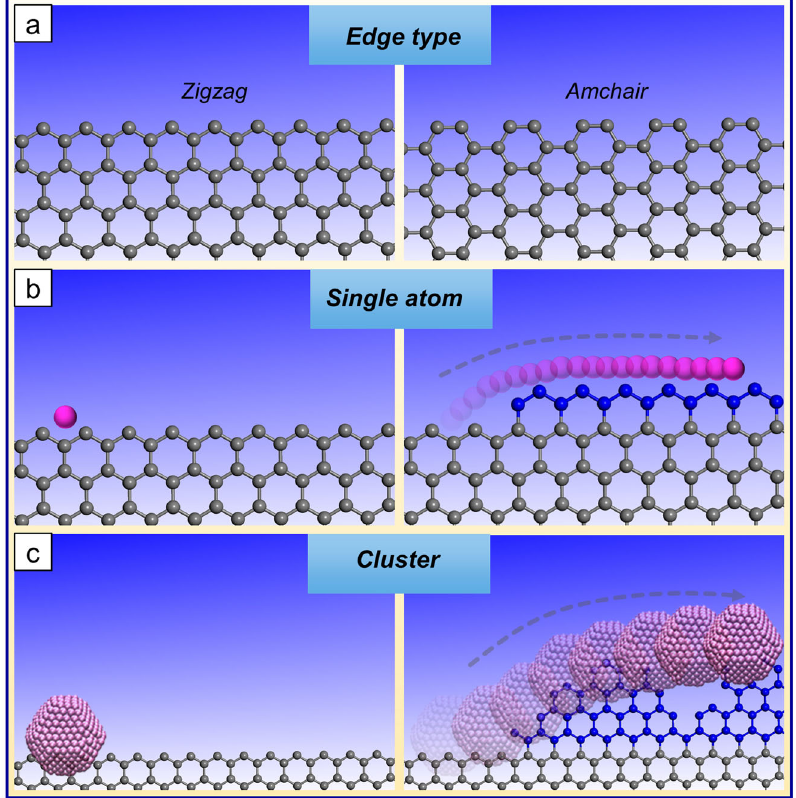
Fig. 1 Schematic of edge growth from a single catalyst atom and from a catalyst nanoparticle. Panel a shows the zigzag and armchair edge termination of graphene. Panel b shows a single-atom edge layer being grown at a graphene edge from a single-atom catalyst and panel c shows the typically rough edge formed from a catalyst nanoparticle/cluster at a graphene edge (growth and